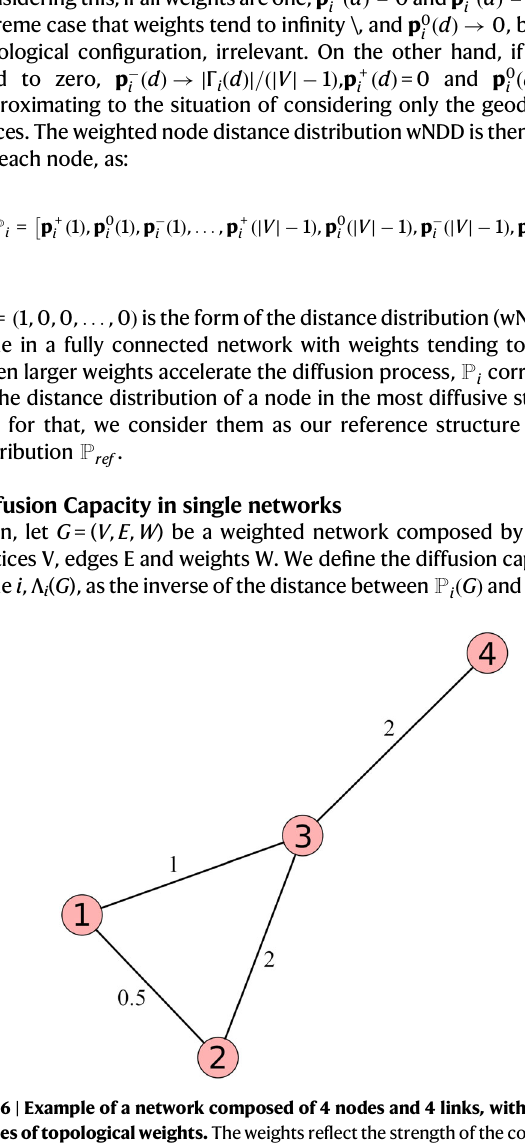
degreeshigherthanthetemperatureoftheothernodes.Thetimeevolutionofthe diffusioncapacityvaluesofthesystemisshownin( C ).Theminimumvalue(DC min ) corresponds to the DC value when ( x j − x i ) →